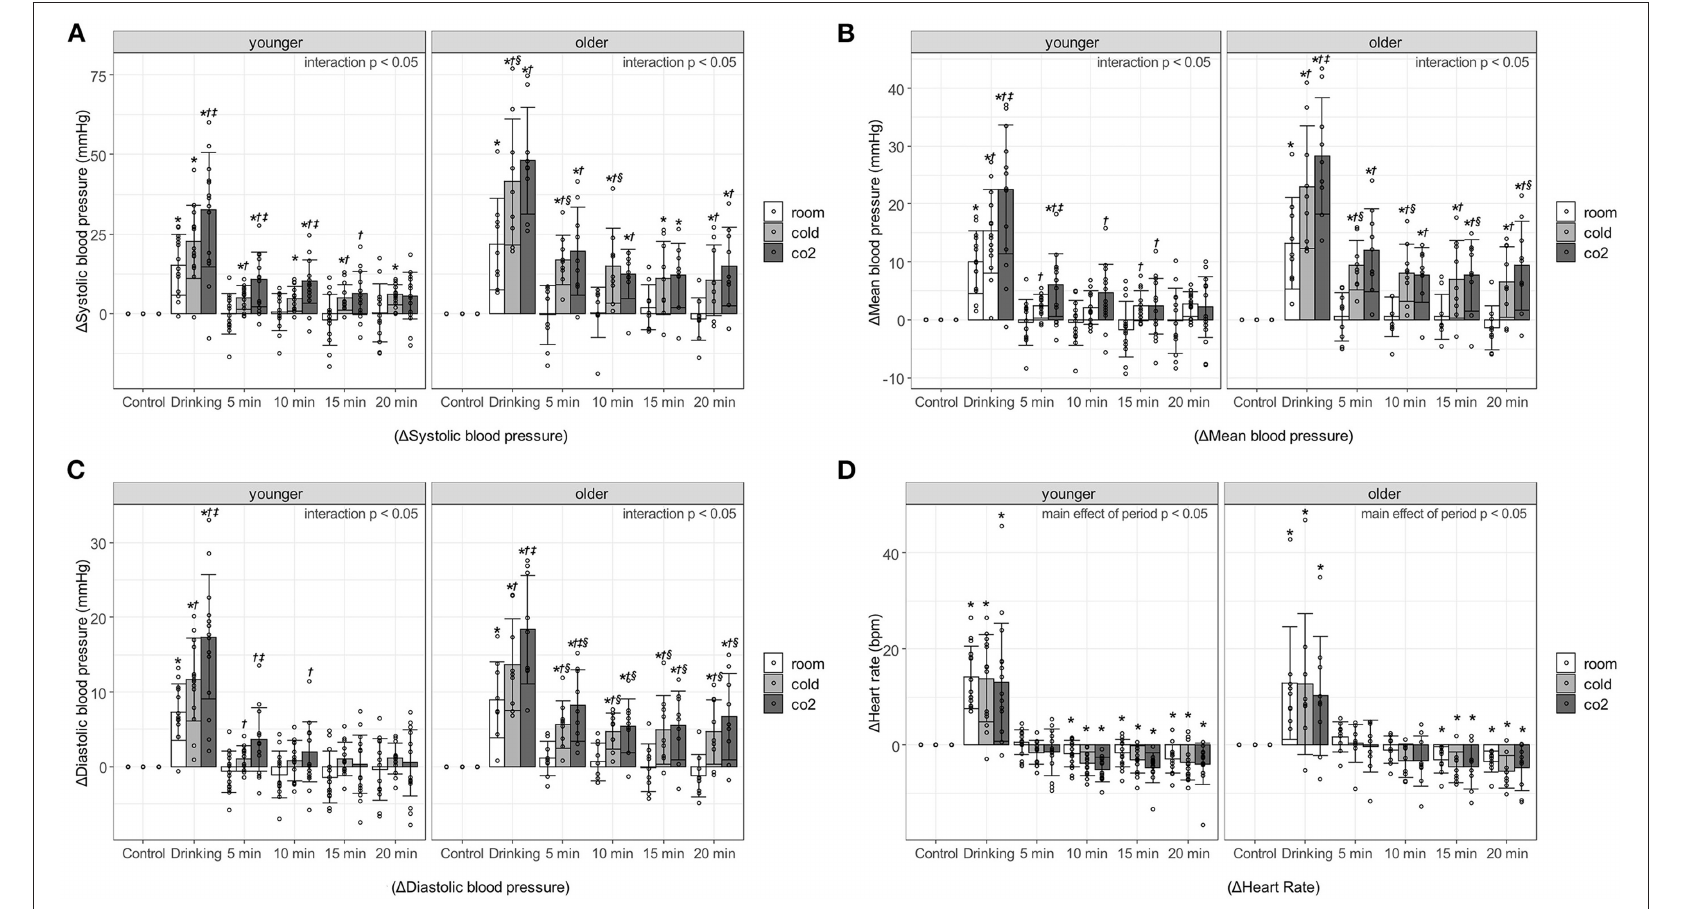
FIGURE 1 | Changes in blood pressure and heart rate against control period, associated with age, water type, and period. (A) Systolic blood pressure. (B) Mean blood pressure. (C) Diastolic blood pressure. (D) Heart rate. Values are shown as mean ± standard deviation, * p < 0.05 vs. control period, † p < 0.05 vs. room, ‡ p < 0.05 vs. cold, § p < 0.05 vs. younger. 5 min, recovery 0-5min; 10 min, recovery 5-10min; 15 min, recovery 10-15min; 20 min, recovery 15-20min. Room, room temperature water; Cold, cold water; CO 2 , cold carbonated